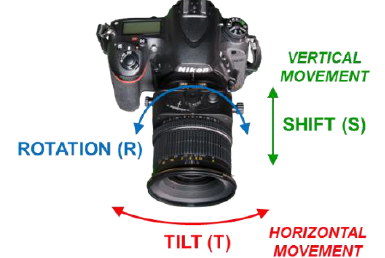
Figure 4. Movements of tilt-shift lens mounted on a DSLR camera with the image plane vertical and